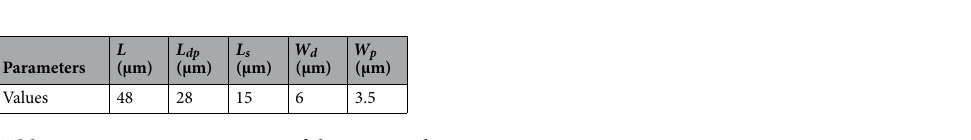
Table 1. Geometric parameters of the proposed